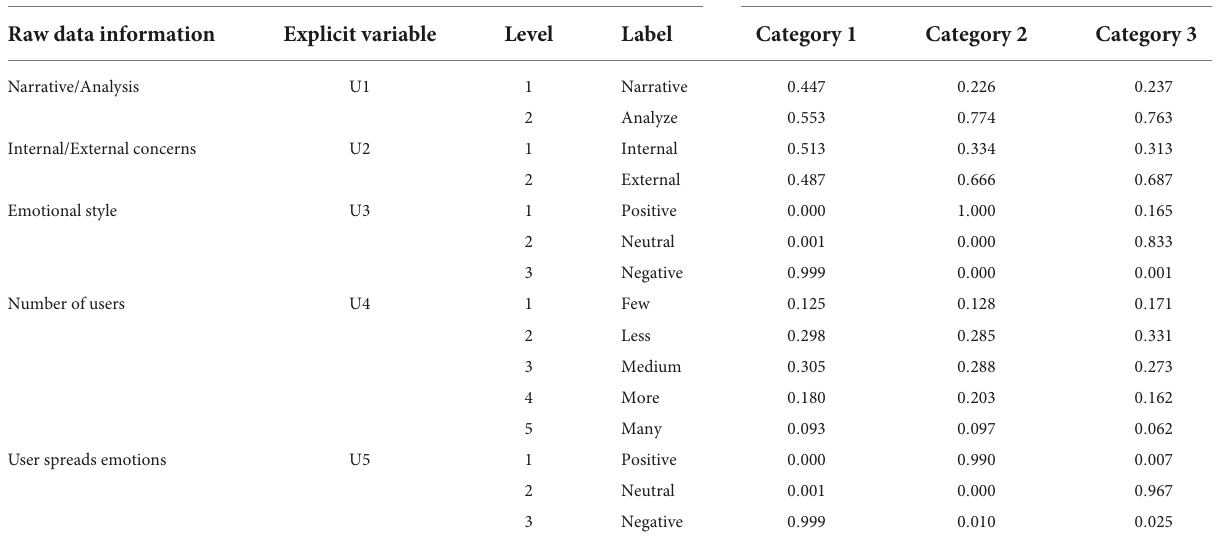
TABLE 5 Model parameter estimation results.